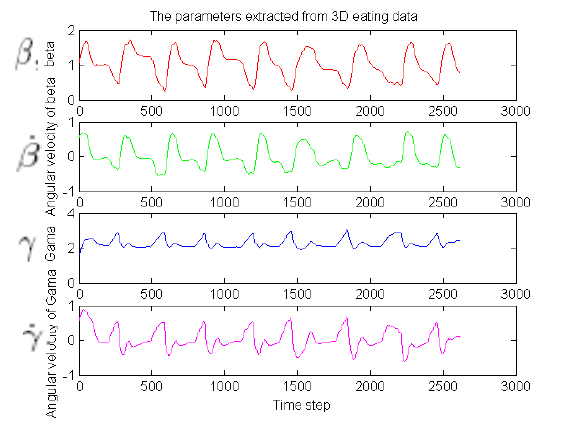
Figure 8. The features extracted from the 3 axis accelerometer of eating activity.